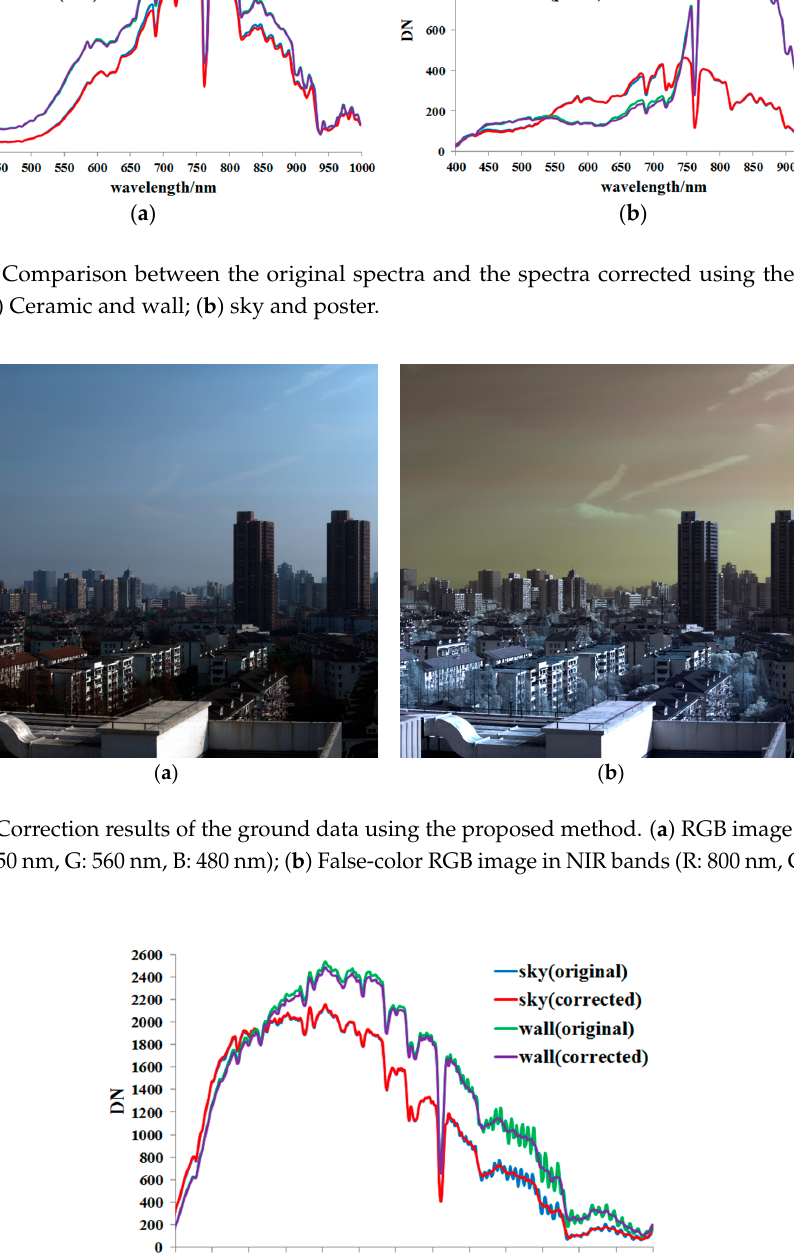
Figure 20. Comparison between the original spectra and the spectra corrected using the proposed